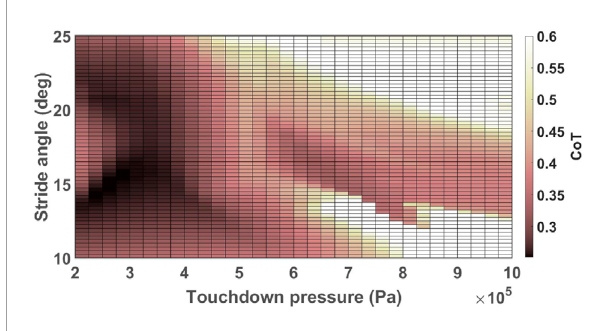
FIGURE 3 Heat map of CoT values for the robot trotting with ω = 105 deg/s on the ground with the stiffness of 100 ± 10 kN/m and the slope of 0 ± 0 . 5°. CoT values greater than 0.6 are displayed in white color to provide sufficient contrast for values closer to the optimal values.